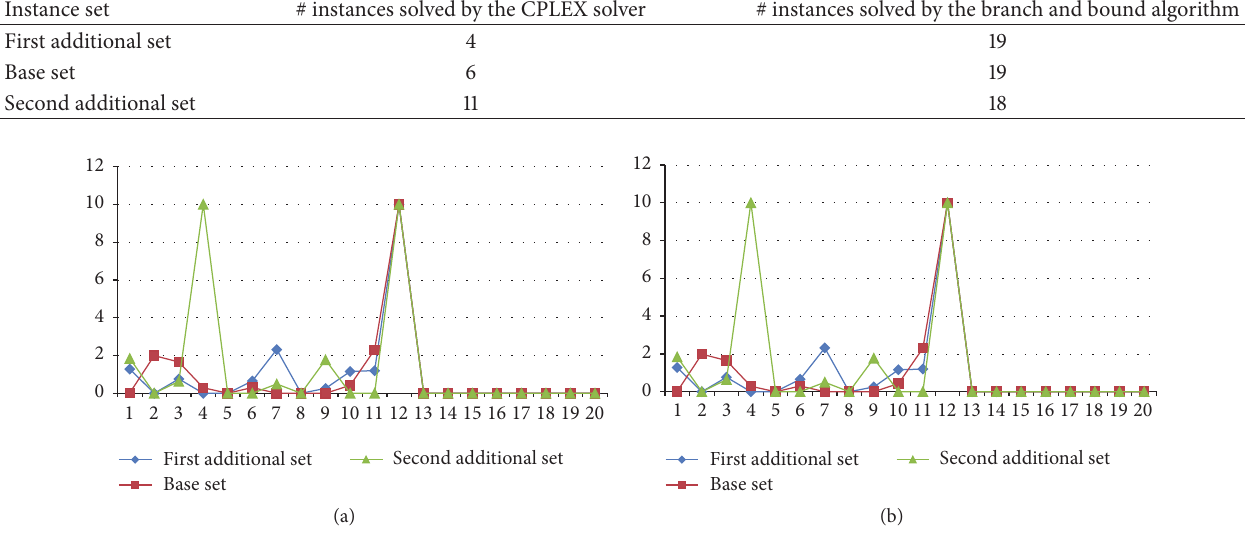
the branch and bound algorithm works remarkably